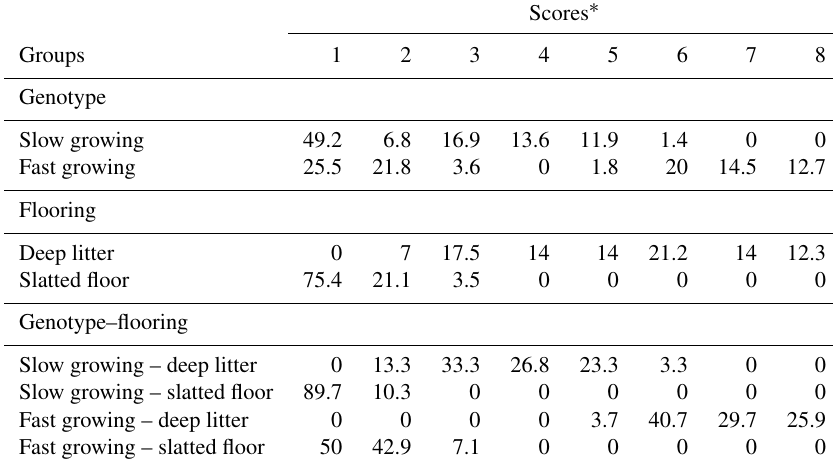
Table 3. Breast feather dirtiness score prevalence in week 8 (%).